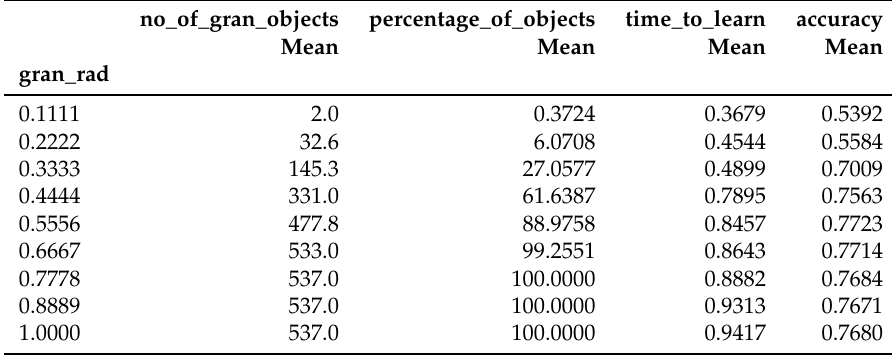
Table 7. Results for Pima Indians Diabetes dataset (mean from 10